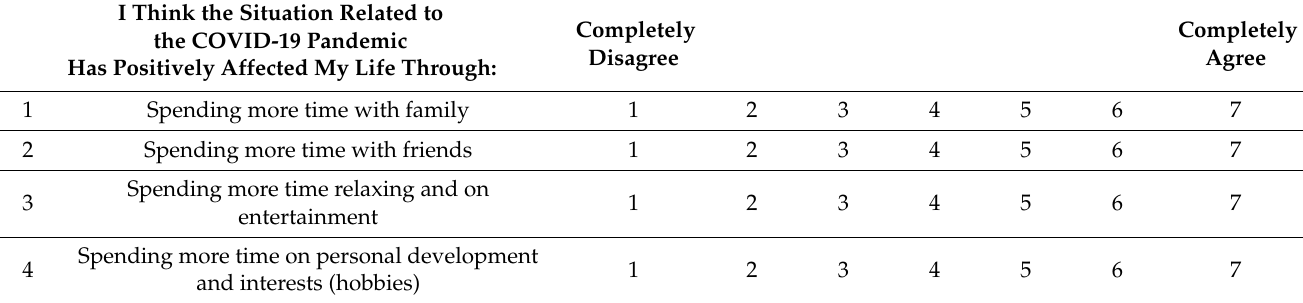
Table A1. The Perceived Positive Lockdown Impact Scale